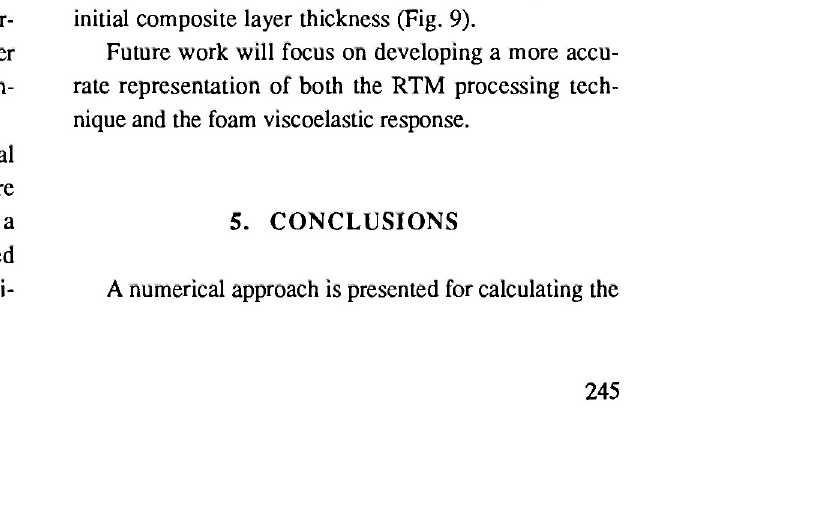
the corresponding equivalent elastic expansion of the composite layers immediately followed (Fig.